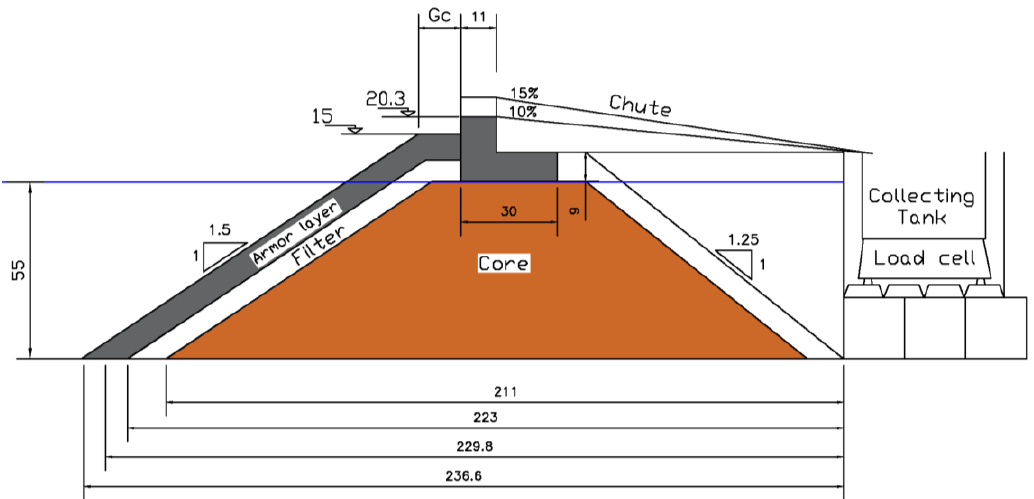
Figure 2. Two-layer Cubipod armored mound breakwater tested by Smolka et al. [12]. Dimensions presented in cm.